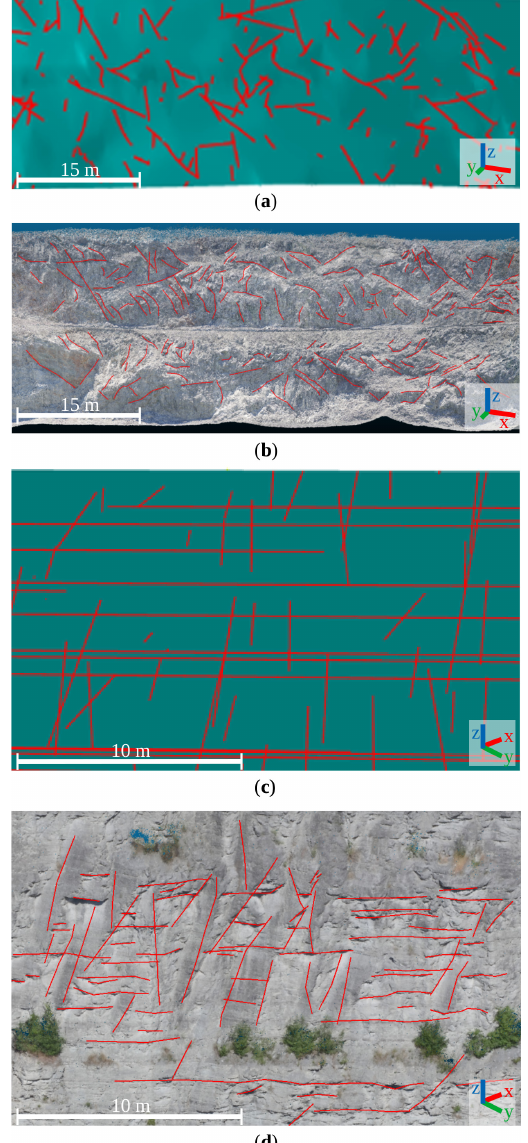
Figure 4. Trace-planes of DFN models (green) generated for ( a ) Mine A and ( c ) Mine B. Red lines represent joint traces. Trace-planes of UAV virtual mapping generated for ( b ) Mine A and ( d ) Mine